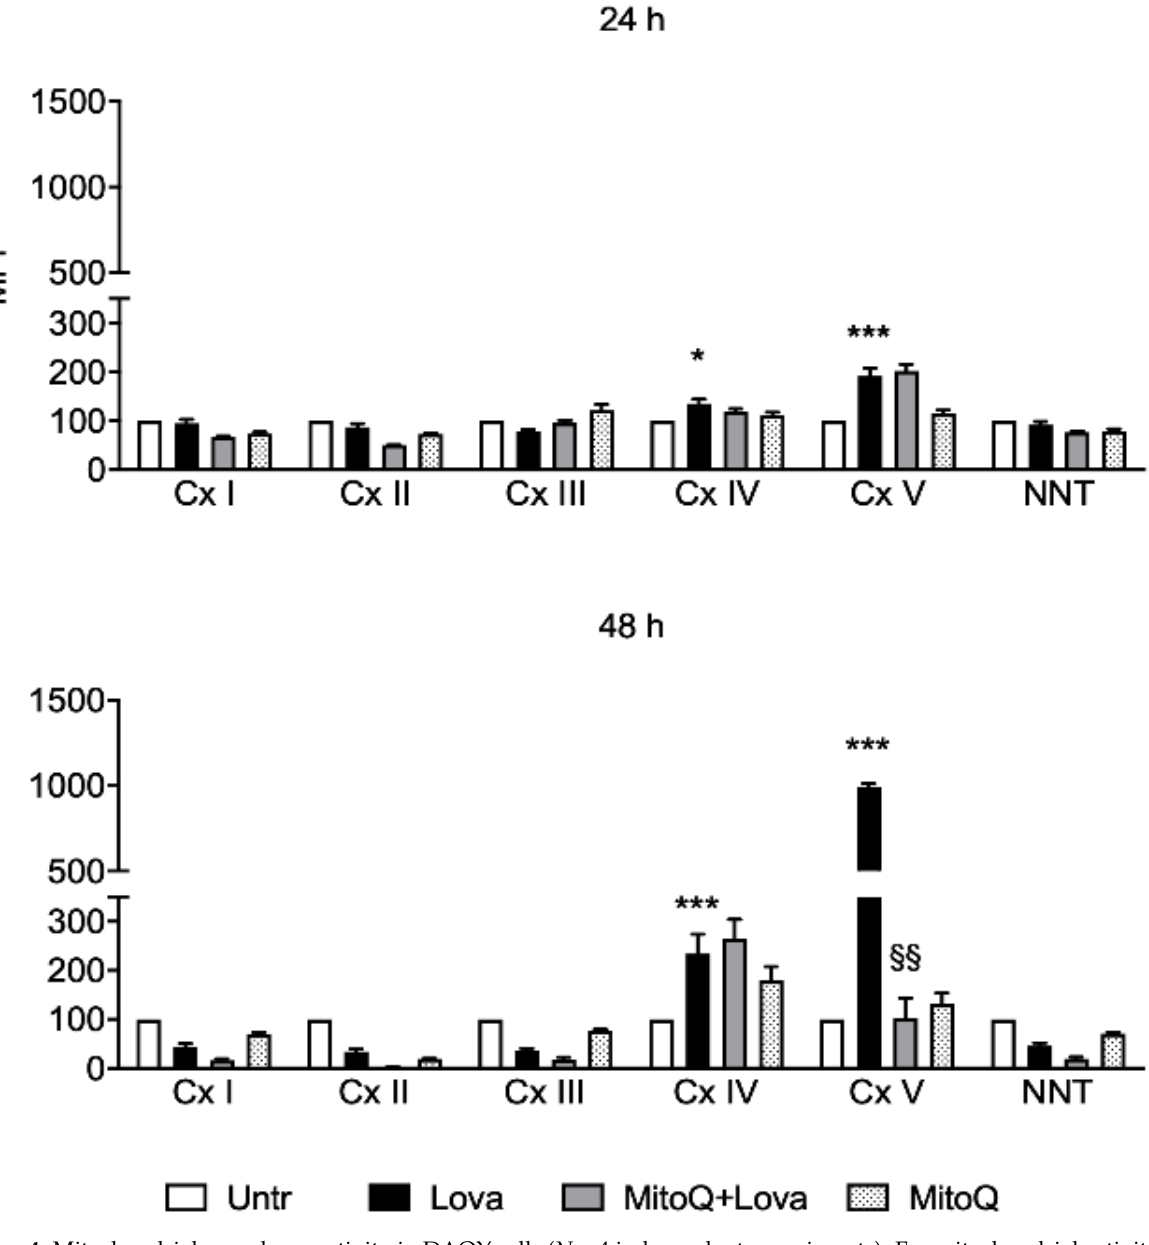
Figure 4. Mitochondrial complexes activity in DAOY cells ( N = 4 independent experiments). For mitochondrial activity measurement, cells were treated with lovastatin and MitoQ for 12/24/48 h and then analyzed with a MILLIPLEX ® human oxidative phosphorylation (OXPHOS) magnetic bead panel. Results are reported as mean ± SD. Statistically significant p -values are shown (two-way ANOVA: Lova vs. Untreated: * p < 0.05; ** p < 0.01; *** p < 0.001; MitoQ + Lova vs. Lova: §§ p < 0.01). Abbreviations: Untr, untreated; Lova, lovastatin; Cx I, NADH-ubiquinone oxidoreductase (Complex I); Cx II, succinate ubiquinone oxidoreductase (Complex II); Cx III, ubiquinone cytochrome c oxidoreductase (Complex III); Cx IV, cytochrome c oxidase (Complex IV); Cx V, ATP synthase (Complex V); NNT, nicotinamide nucleotide transhydrogenase.